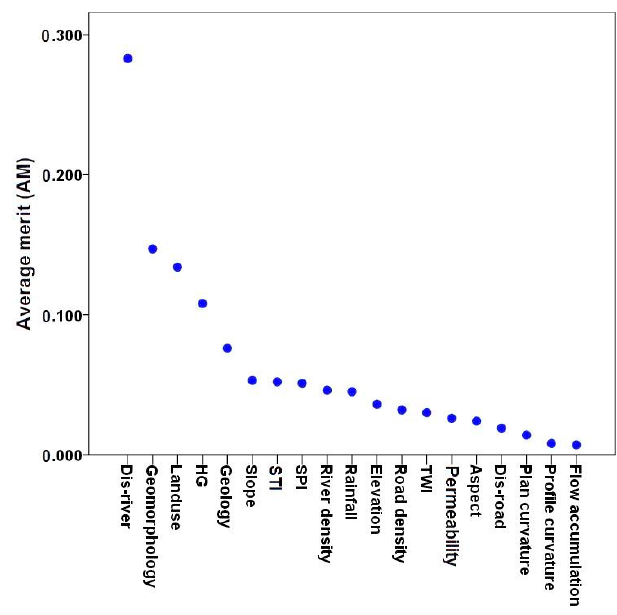
Figure 4. The most important conditioning factors for gully erosion modeling in the Klocheh Watershed, Kurdistan Province, Iran.